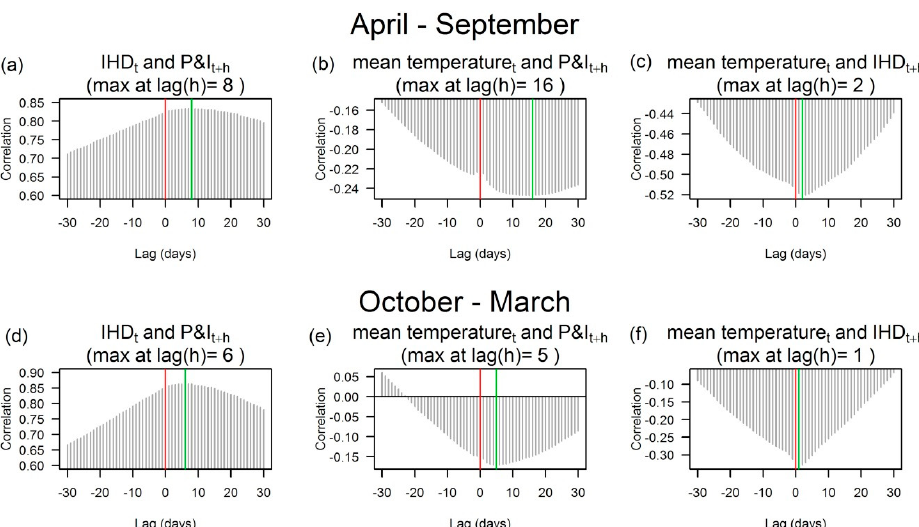
Figure 4. Cross-correlations of daily P&I and IHD deaths and daily temperatures among the population aged 65 or older in Japan, 1973–2009. Cross-correlations identify the lags ( h ) of one variable ( x t ` h ) relative to the other ( y t ). The red vertical line at lag 0 is for the same day ( t ). The green vertical line highlights the lag h with the largest cross-correlation. The correlograms show the cross-correlations of ( a ) IHD and P&I deaths; ( b ) mean temperature and P&I deaths; ( c ) mean temperature and IHD deaths in a warm season (April to September); ( d ) P&I deaths; ( e ) mean temperature and P&I deaths; and ( f ) mean temperature and IHD deaths in a cold season (October to March).